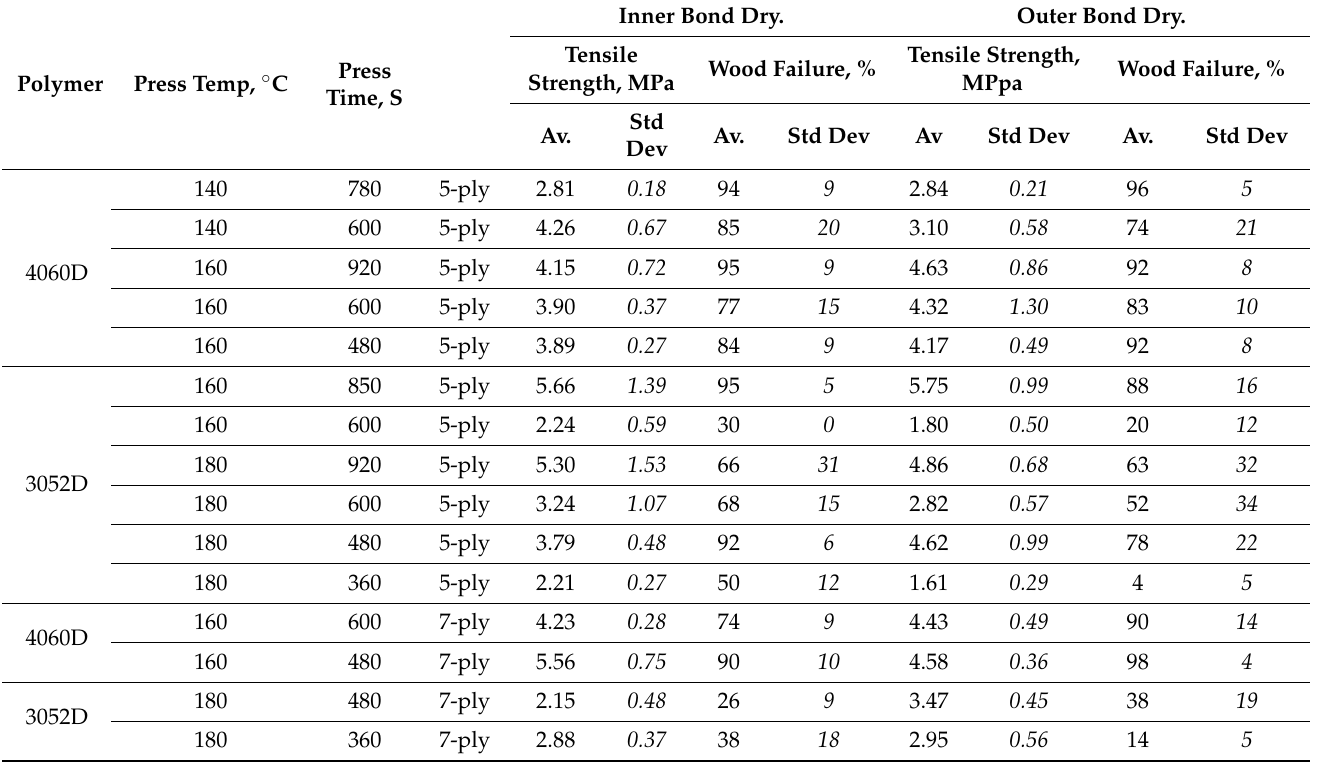
Table 3. Summary of tensile testing results of 5-ply and 7-ply panels formed with radiata pine veneer and semi-crystalline and amorphous PLA grades at differing pressing temperatures and times before